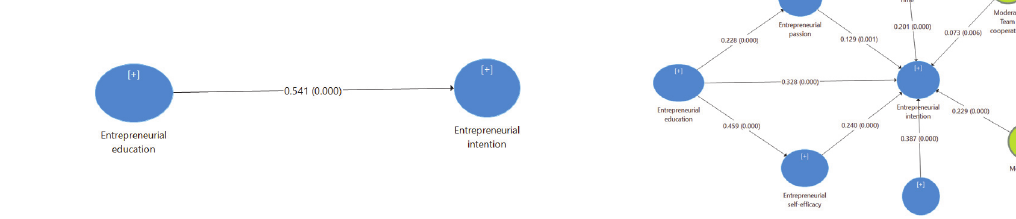
Fig. 4. The direct impact result of Entrepreneurial educa- tion on Entrepreneurial intention